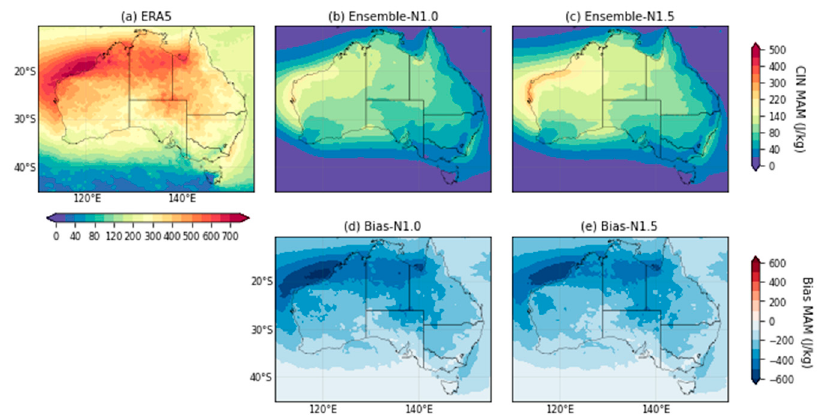
Figure A8. As in Figure A7 except for DJF.